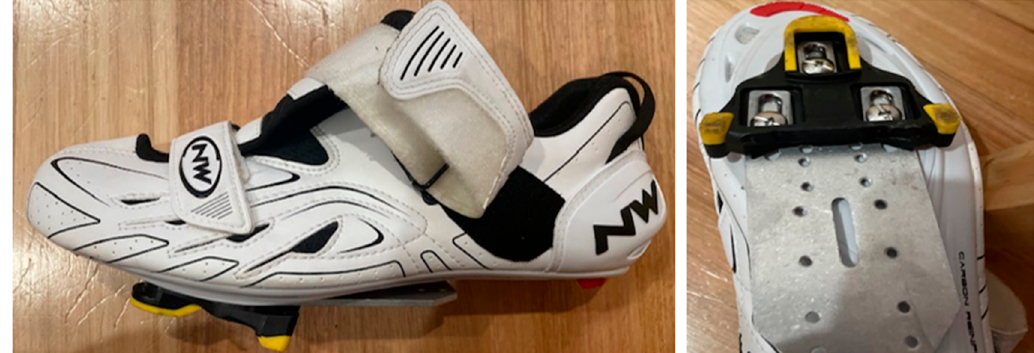
Figure 5. Northwave tri-sonic cycling shoe used in study with cleat plate securely fastened. Cleat position shown is POS with yellow Shimano SPD-SL cleat securely fastened to the cleat plate.